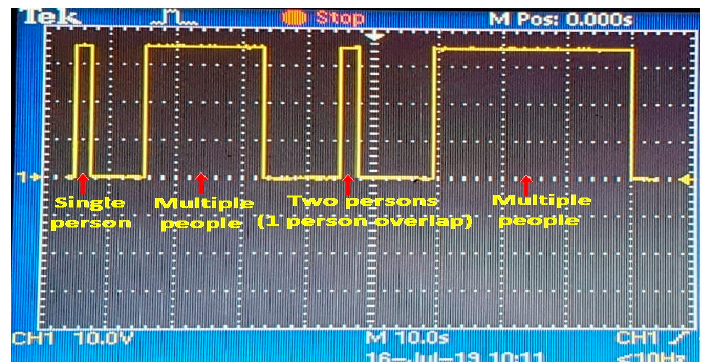
Figure 5. Change in duration of HIGH state of the passive infrared (PIR) sensor due to single and multiple passerby.